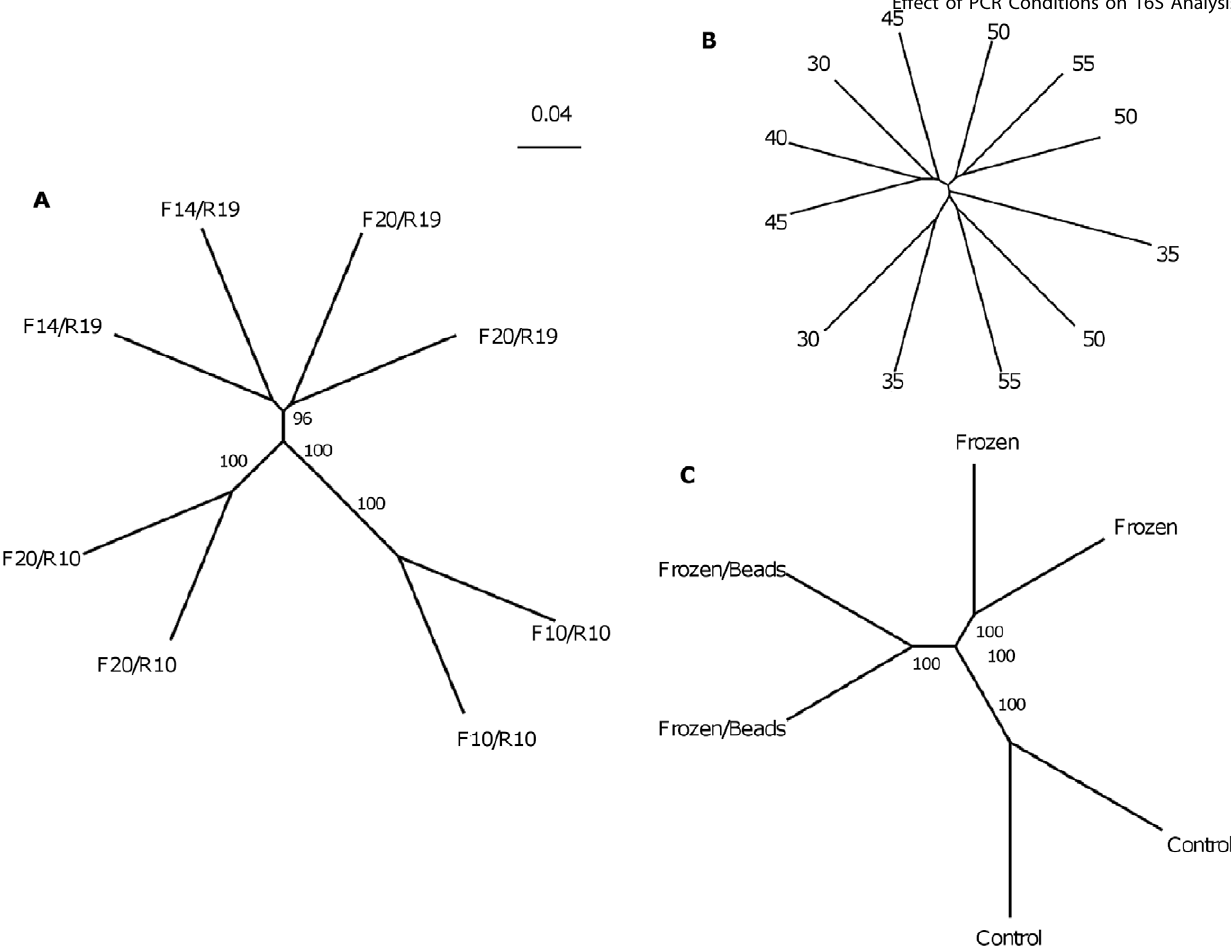
Figure 3. PCA visualization of the differences between the observed bacterial communities as judged by pyrosequencing generated by different experimental procedures. (a) Different primer pairs (b) Different annealing temperatures (c) Different extraction procedures. Table 4. OTUs which showed correlation with annealing temperature.